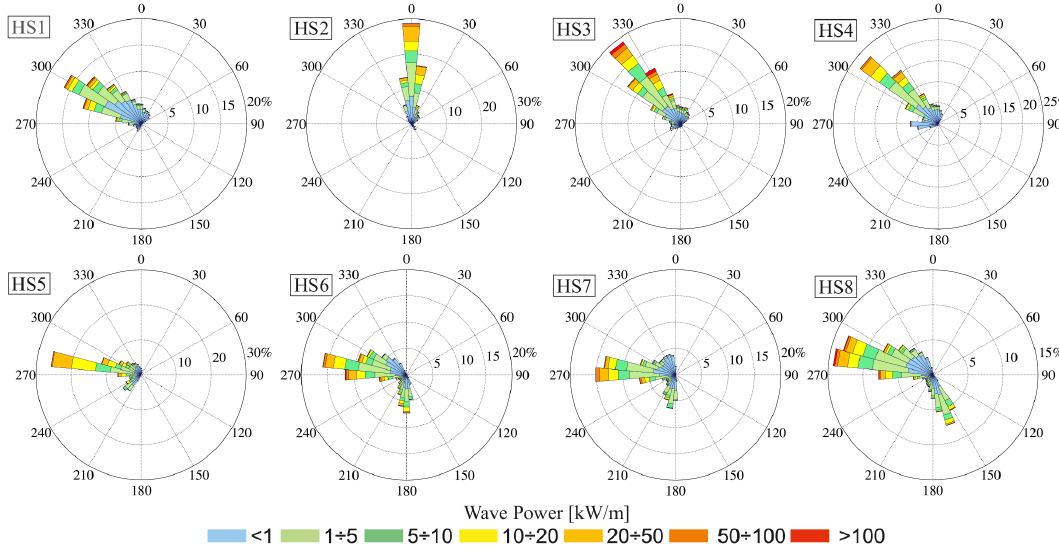
Figure 16. Wave power climate for the sites